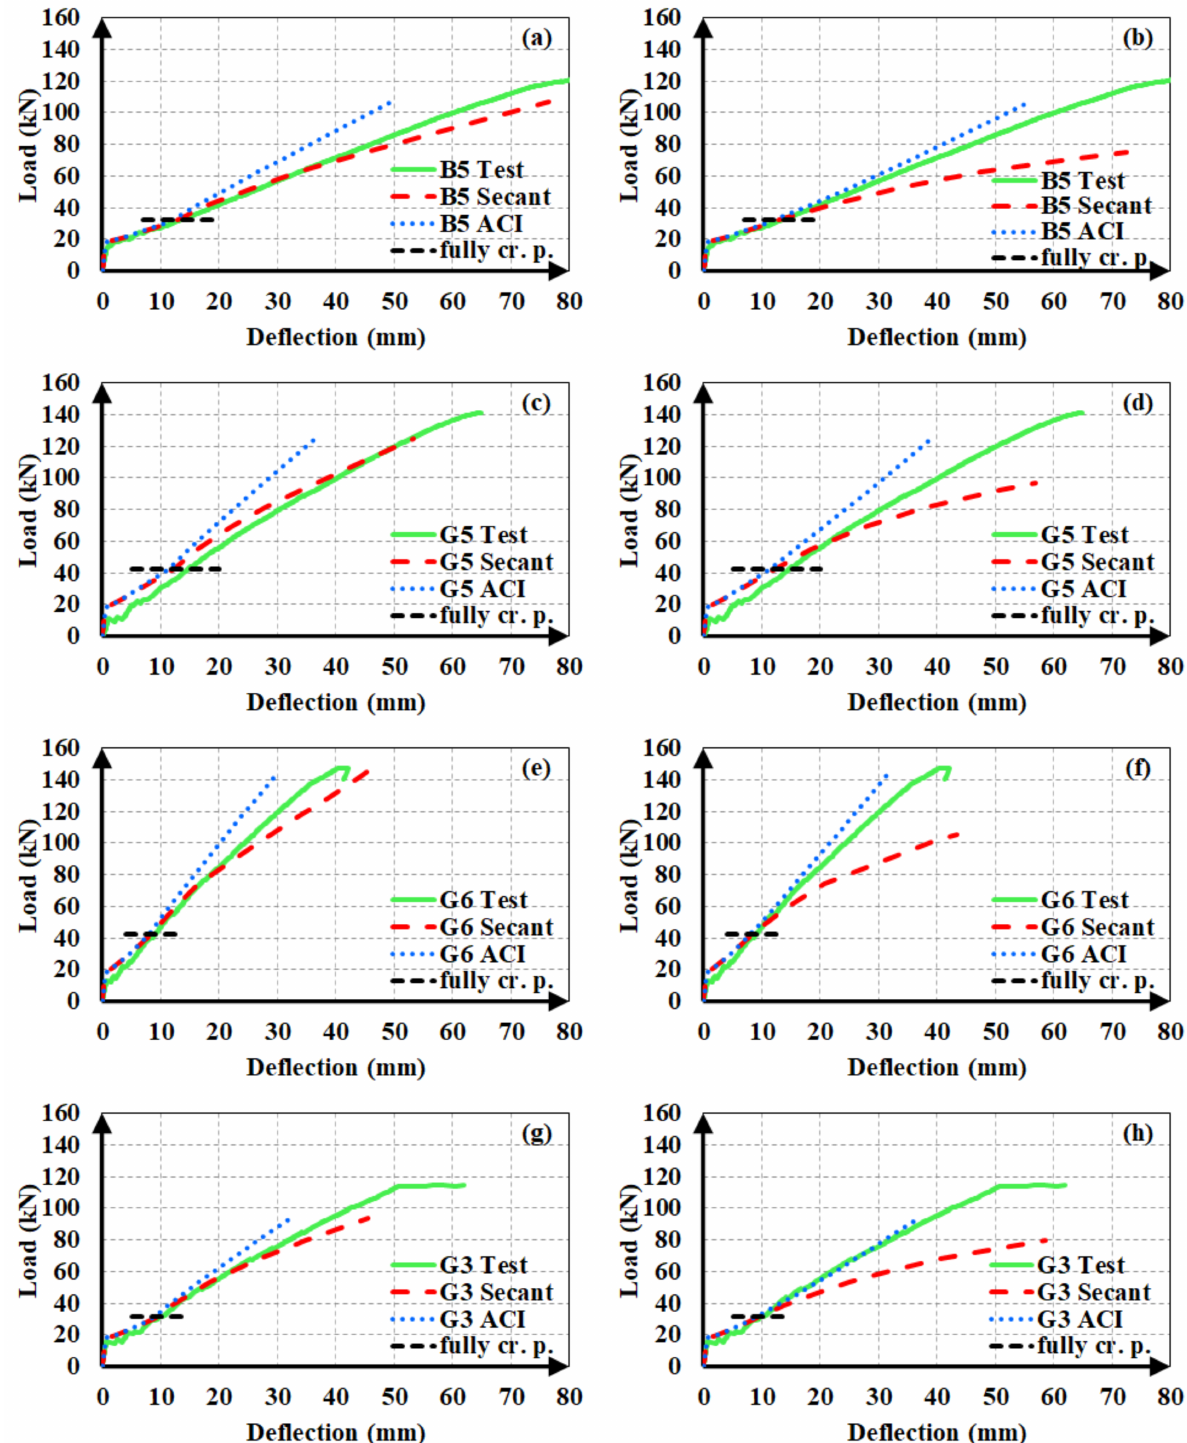
Figure 16. Load-deflection estimates of FRP RC beams from ( a , c , e , g ) Model-A and ( b , d , f , h ) Model-B. The ACI 318M-19 [32] definition provides closer deflection estimates when used in combination with Model B. The use of the secant modulus of elasticity in Model B resulted in excessive and over-conservative deflection values once the section was fully cracked. Accordingly, the secant modulus of elasticity should be preferred when applying Model A, yet the ACI 318M-19 [32] definition should be adopted when using Model